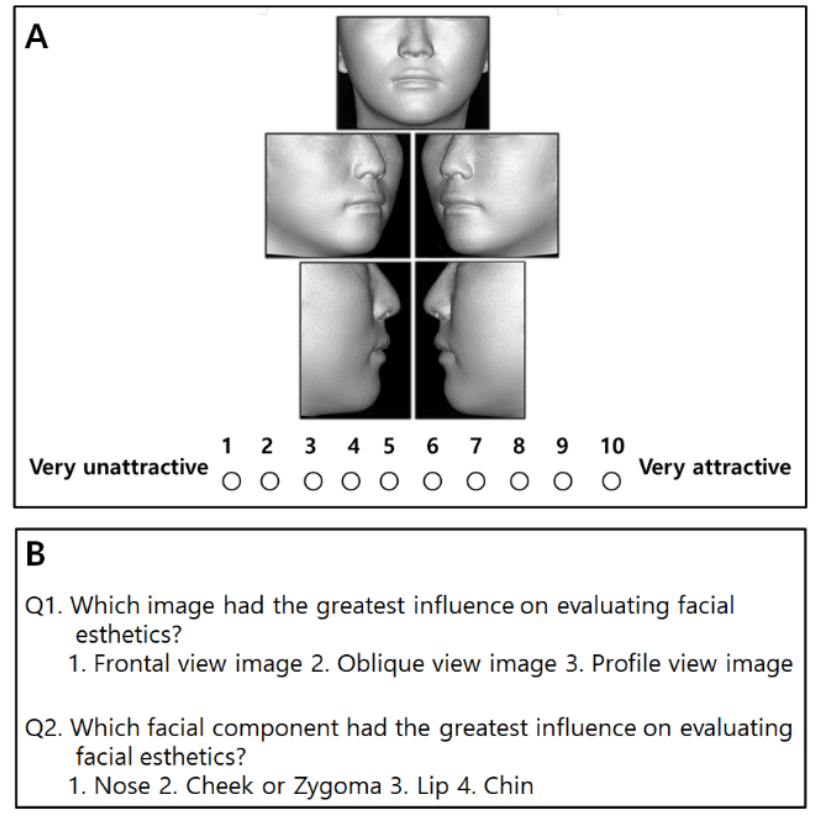
Figure 4. The questionnaire used to evaluate facial soft tissue esthetics. ( A ) Facial three-dimensional images and a numeric rating scale (NRS). ( B ) The two questions on the last page.